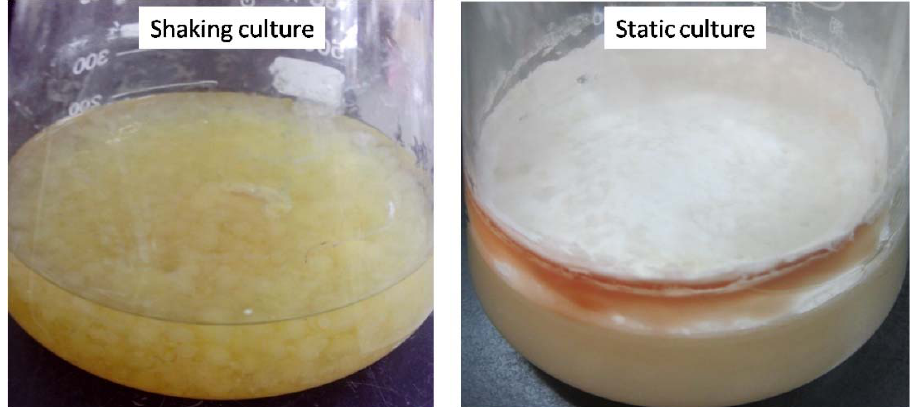
Figure 5. Comparison of the characteristics of mycelia under shaking and at static culture conditions.